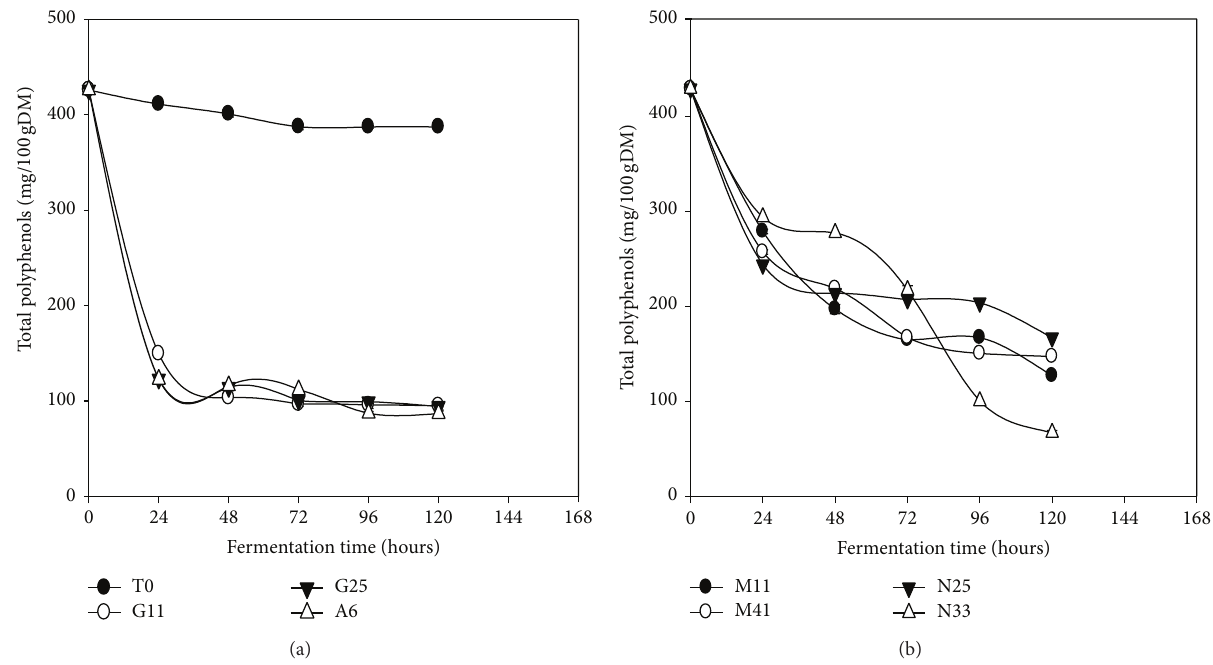
Figure 6: Evolution of total polyphenols in Kutukutu during fermentation by the various LAB at 25 ∘ C (T0 = control; G11 = L. brevis G11; G25 = L. brevis G25; A6 = L. plantarum A6; M11 = L. buchneri M1; M41 = L. cellobiosus M41; N33 = L. fermentum N33; N25 = L. fermentum N25).